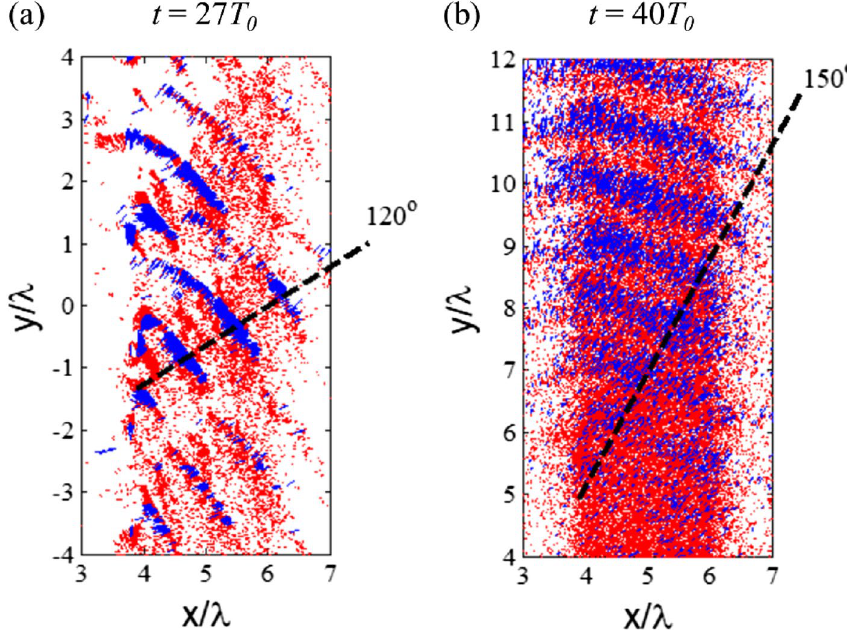
Figure 7. The transient electron emission patterns with the Gr500 target at ( a ) t = 27 T 0 ; and ( b ) t = 40 T 0 .